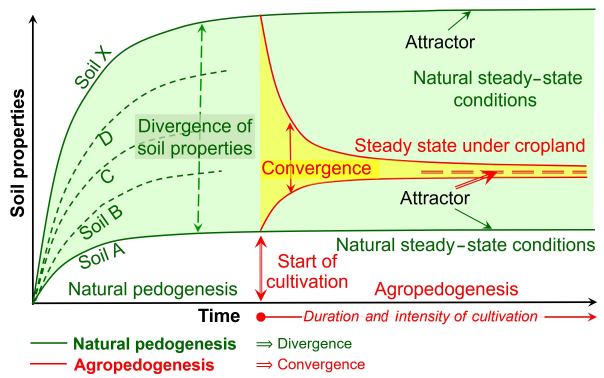
Figure 1. Conceptual scheme of soil development, i.e. pedogen- esis, under natural conditions (green lines) and agropedogenesis due to long-term agricultural practices (red lines). Green area: the increasing variability in natural soils during pedogenesis. Yellow area: decrease in the variability in soil properties by agricultural use. Double-line vertical arrow: the start of cultivation. x axis: time for natural soil development and duration and intensity of cultiva- tion under agricultural use. Natural pedogenesis leads (from the ini- tial parent material) to a wide range of steady-state values (green dashed arrow) for a given soil property over hundreds or thousands of years due to various combinations of the five soil-forming fac- tors. Natural pedogenesis leads to divergence of soil properties. In contrast, agricultural practices and the dominance of humans as the main soil-forming factor cause each property to tend toward a very narrow field of values, i.e. attractors of that property defined by hu- man actions, namely land management for optimizing the produc- tion of few crops. Therefore, agropedogenesis leads to convergence of soil properties.